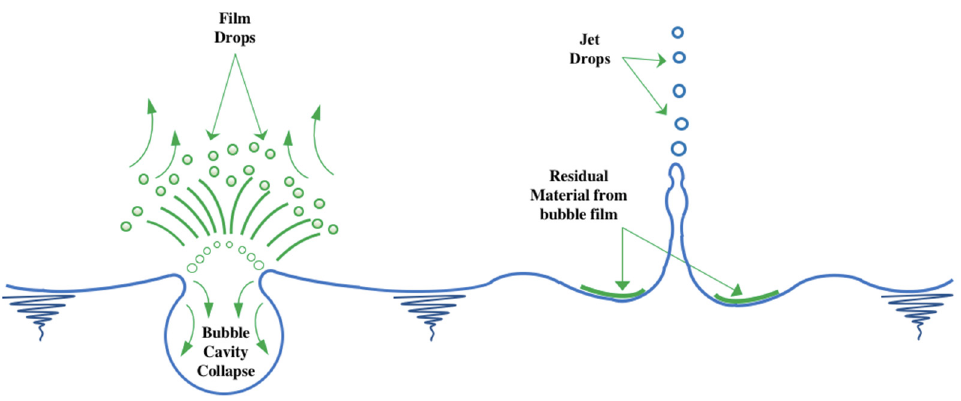
Figure 1. Formation of film droplets and jet droplets.